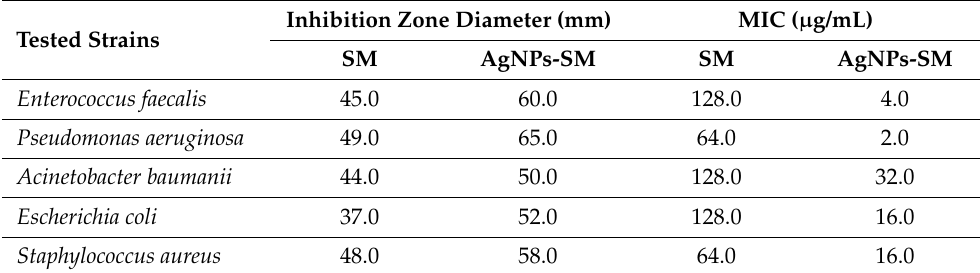
Table 2. Antibacterial activity of the snail mucus and the biosynthesized AgNPs-SM. Tested